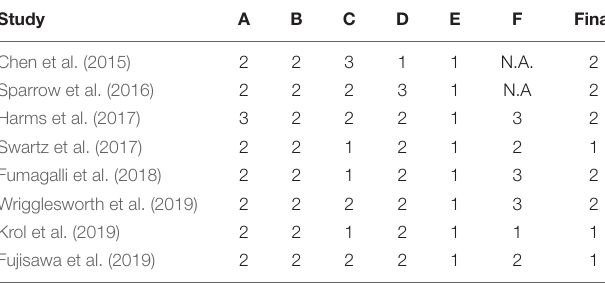
TABLE 1 | Quality appraisal of the included